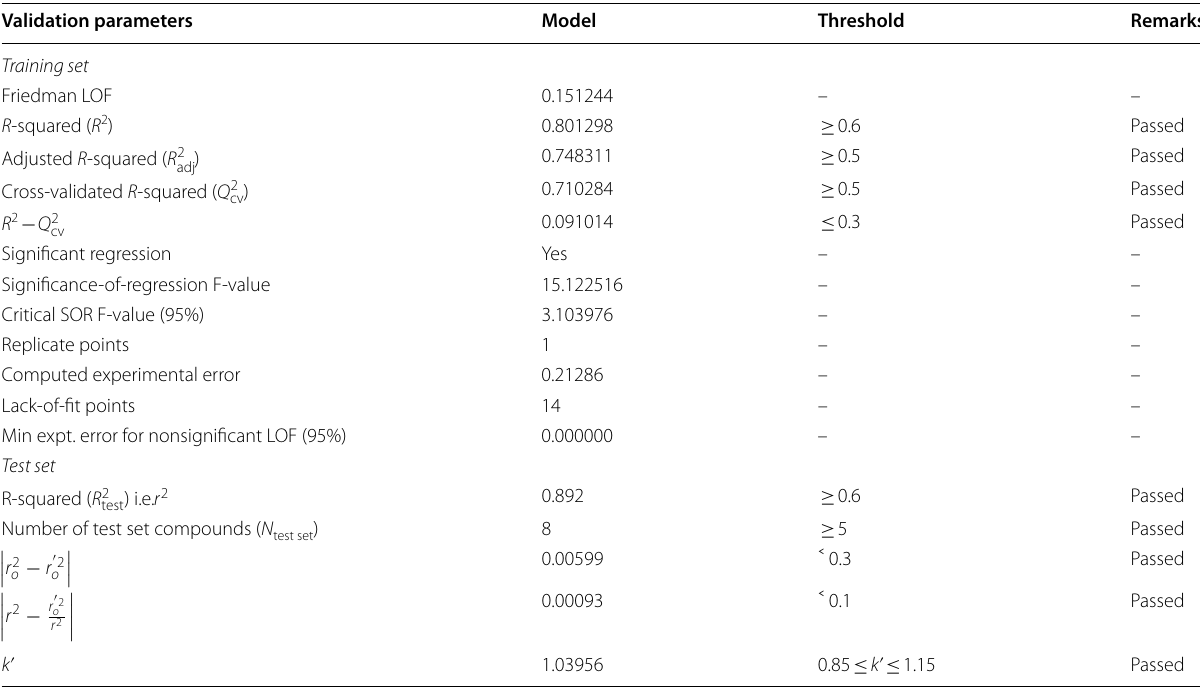
Table 5 Validated parameters of the QSAR model Validation